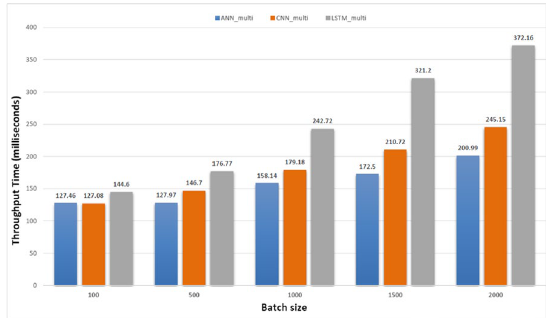
Fig. 20 Throughput of multi-classification based on batch